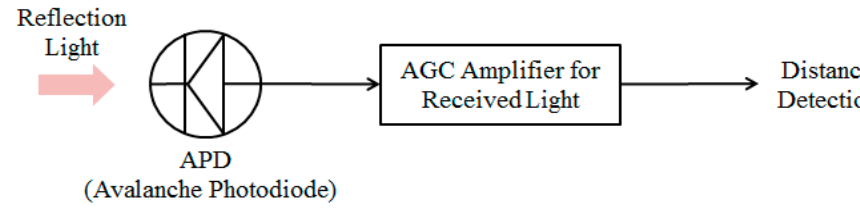
Figure 3. Data processing of the LRF.